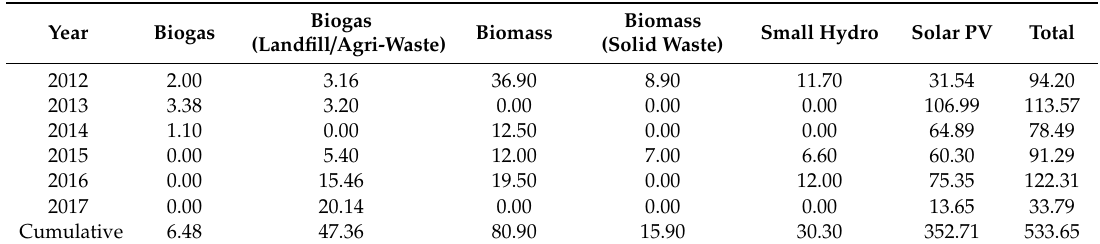
Table 1. Installed Capacity (MW) of Commissioned RE Installations (FiT Program) (source: Sustainable Energy Development Authority Malaysia [22]).